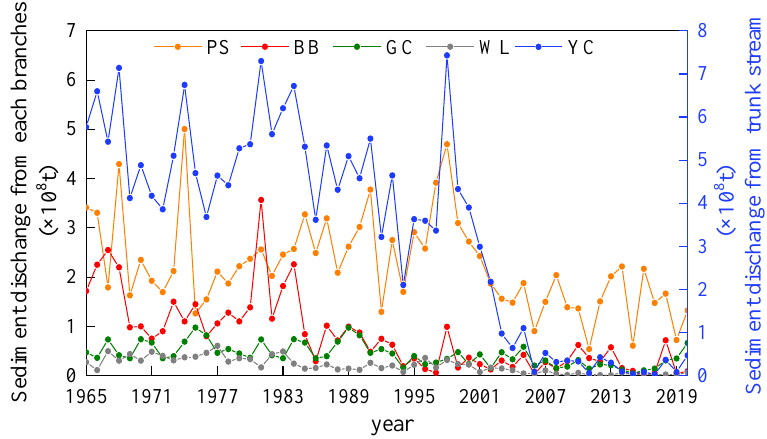
Figure 3. Average annual sediment discharge in the upper reaches of the Yangtze River. Table 2. TFPW–MK trend test of runoff and sediment transport at major hydrological stations in the upper reaches of the Yangtze River.